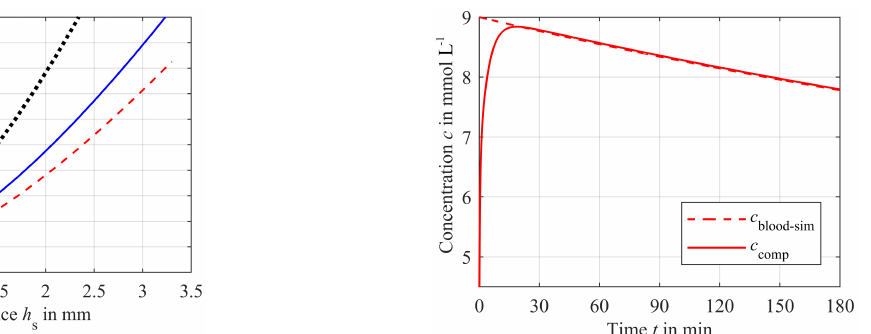
Figure 6. Response of the sensor compartment potassium con- centration c comp (solid line) to a time-dependent blood potassium concentration c blood − sim for a distance h s of 0.9mm. The initial compartment concentration is 4.5mmolL − 1 . The difference c (cid:49) be- tween the initial value of c blood − sim = 9mmolL − 1 and end value of c blood − sim = 4.5mmolL − 1 decreases exponentially with 10% per